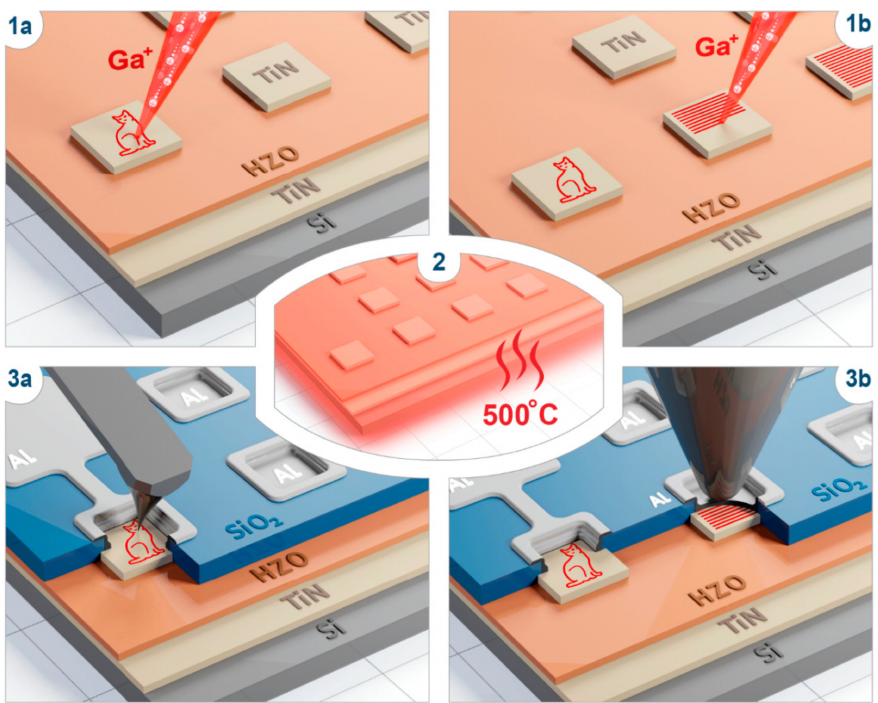
Figure 1. Design of the experiment. First step: The focused ion beam raster scans across the capacitor, implanting Ga ions either ( 1a ) locally or ( 1b ) homogeneously. Second ( 2 ) step: annealing takes place for crystallization of HZO (HZO) either into the ferroelectric phase or into the polymorphic state. Third step: Capacitors are addressed microscopically and macroscopically, either by a PFM study ( 3a ) or electrophysical characterization at a probe station ( 3b